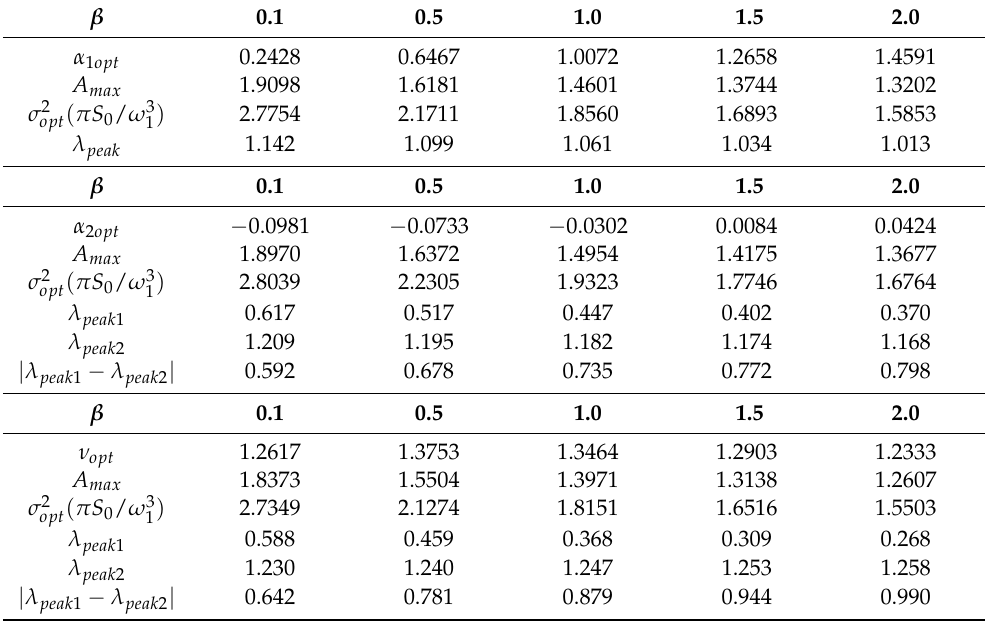
Figure 7. Comparison between the numerical solution and analytical solution when optimizing the single variable ξ ( α 2 opt = α 2 b ): ( a ) µ = 0.1; ( b ) µ = 0.2; ( c ) µ = 0.3; ( d ) µ = 0.4. Table 3. The specific parameters of the system in different inerter-to-mass ratios when optimizing the other variables ( α 2 opt = α 2 b , µ =